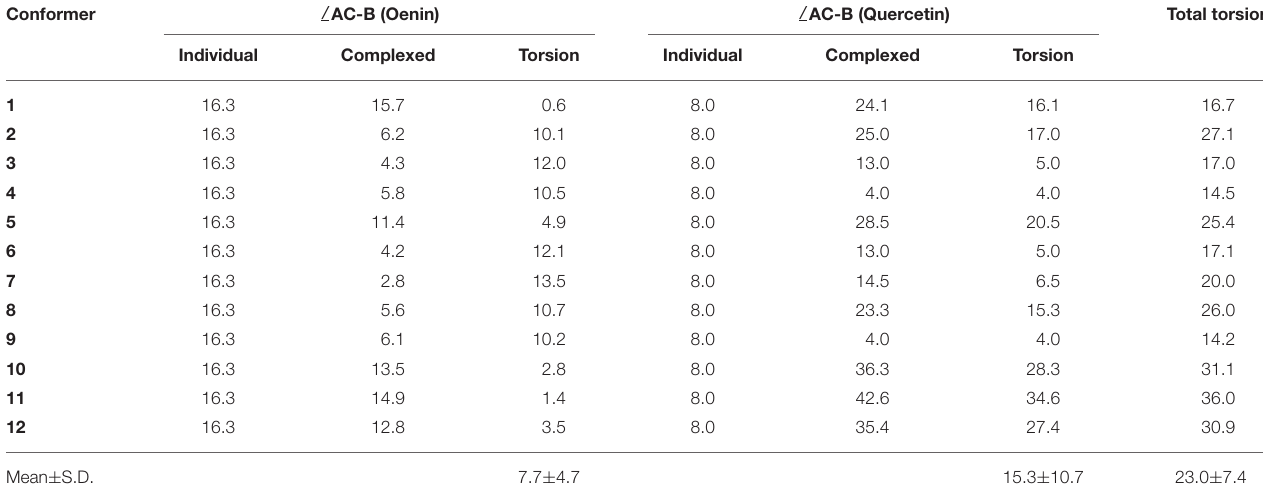
TABLE 2 | Inter-ring torsion angle between AC-rings and B-ring (in degree) a .